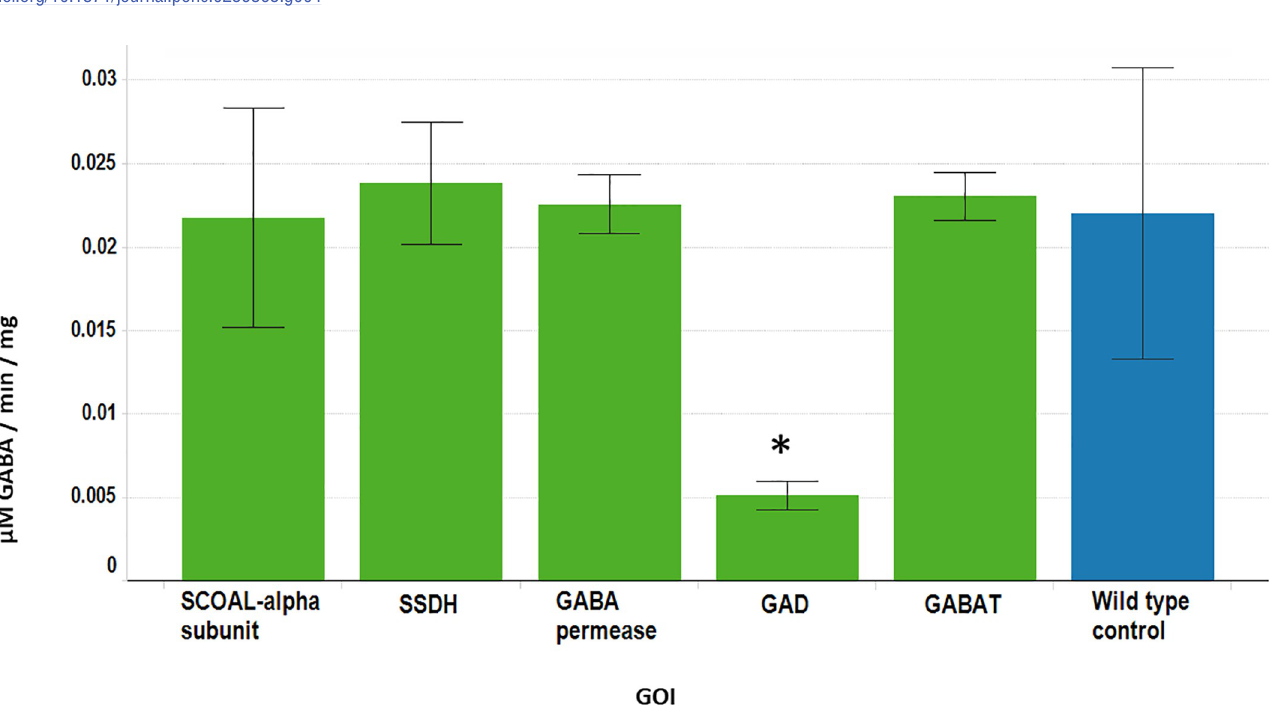
Fig 5. GAD activity in the leaves of GABA pathway suppression mutants. The values represent means of duplicate measurements of 5 separate plants. Green bars represent transgenic plants, blue bars represent wild-type plants. An asterisk marks those lines significantly different than wild type (p < 0.05).